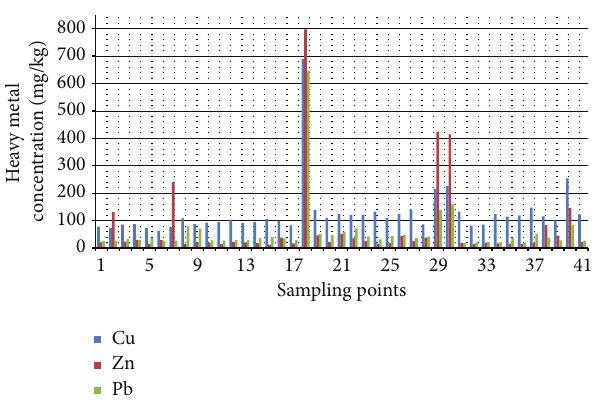
Figure 3: The results of the XRF analysis regarding Copper, Zink and Lead of the selected